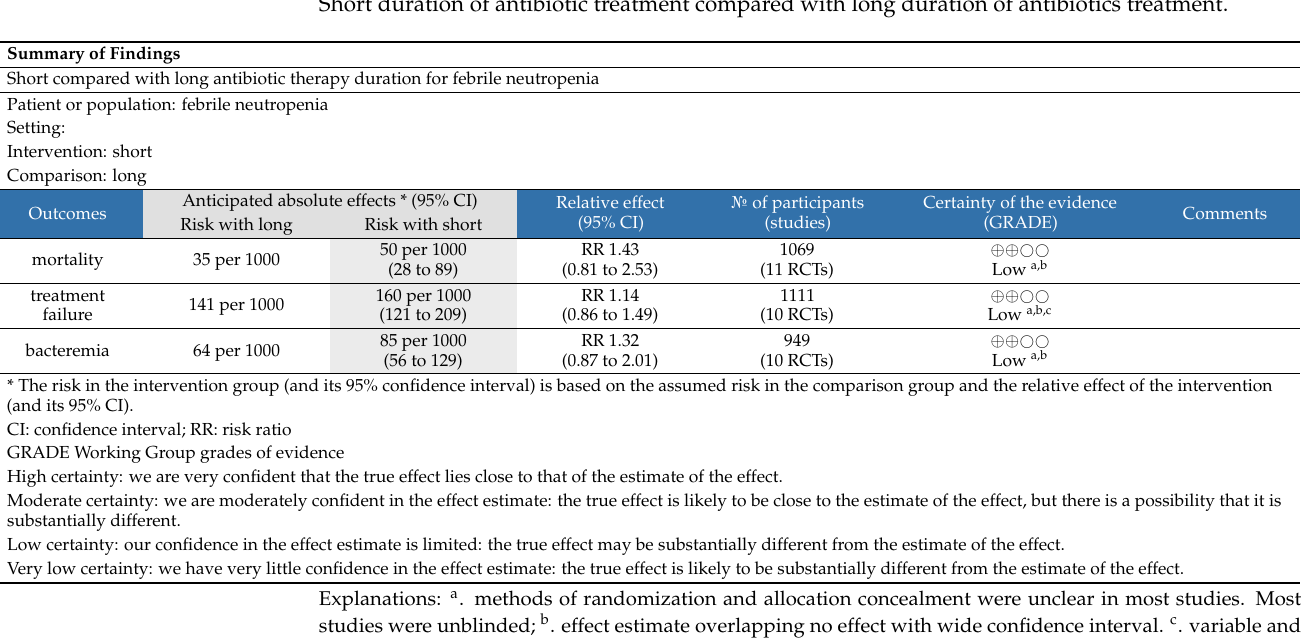
Table 3. Summary of findings for mortality, clinical failure, and bacteremia in our systematic review. Short duration of antibiotic treatment compared with long duration of antibiotics